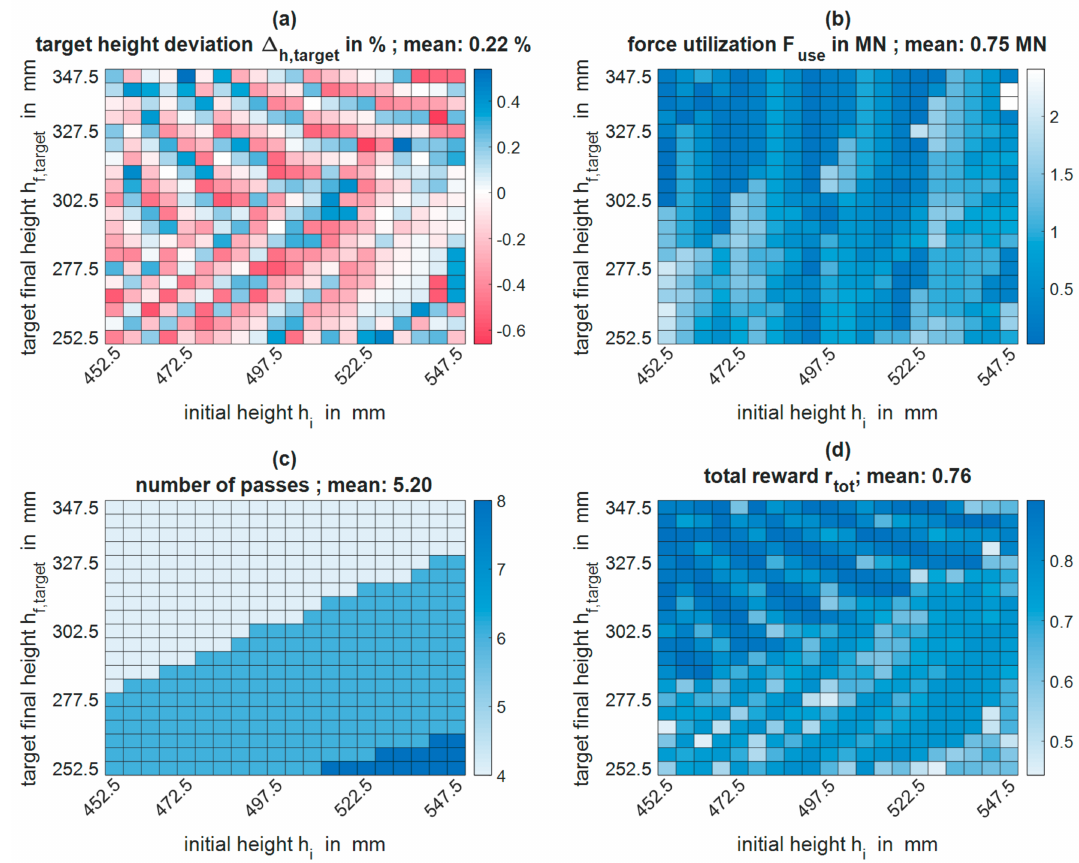
Figure 9. Heatmaps of the training results of the overall best agent: ( a ) the target height deviation, ∆ h , target , ( b ) the mean force utilization, F use , ( c ) the mean number of passes, n p , and ( d ) the total reward, r tot